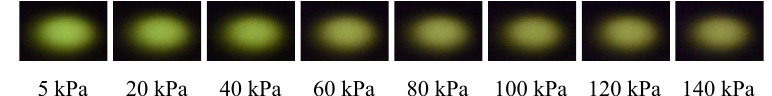
Figure 11. Photographs of the excited chameleon luminophore in the polymer at different pressures taken by a single lens reflex camera (D3400, Nikon). The exposure time was 0.01 s. ISO sensitivity was 25,600. The aperture was f/6.3.